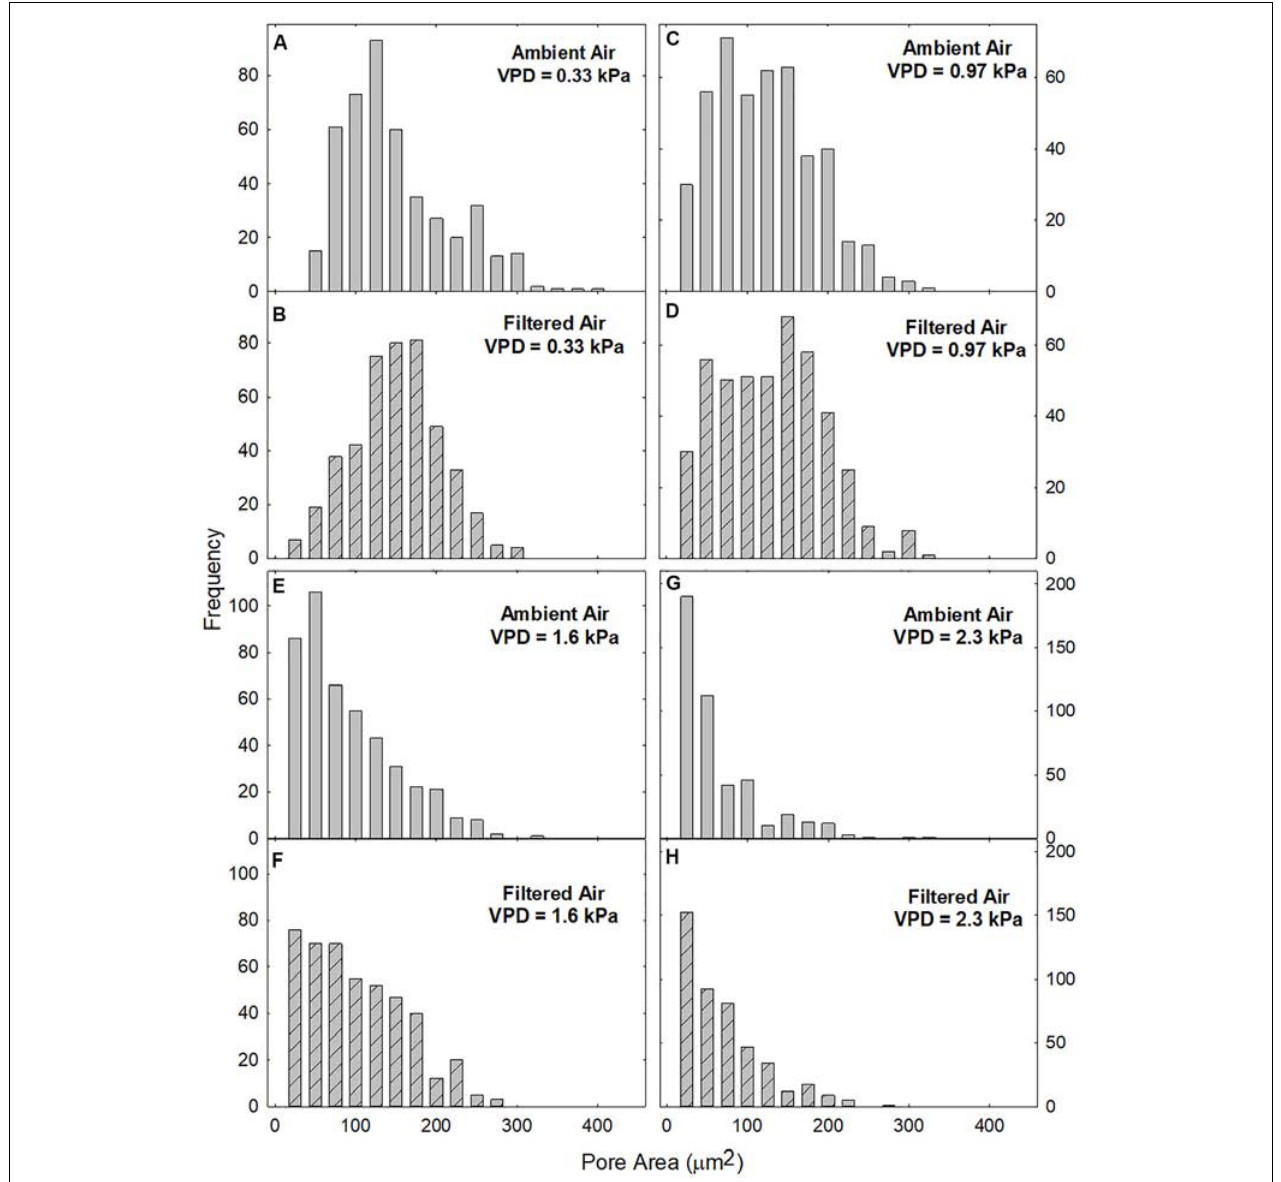
FIGURE 3 | Frequency distribution of pore areas (A) at different levels of evaporative demand (VPD), in leaves exposed to ambient (gray bars; A,C,E,G ) or filtered (hatched bars; B,D,F,H ) air. Area classes: 0 ≤ A < 50 to 400 ≤ A < 450, centered at 25–425. The smallest visible bars represent 1